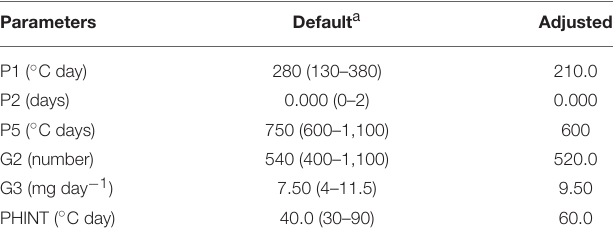
TABLE 1 | Default and adjusted genetic coefficients of maize cv. DMR-ESR-W used in CERES-Maize.